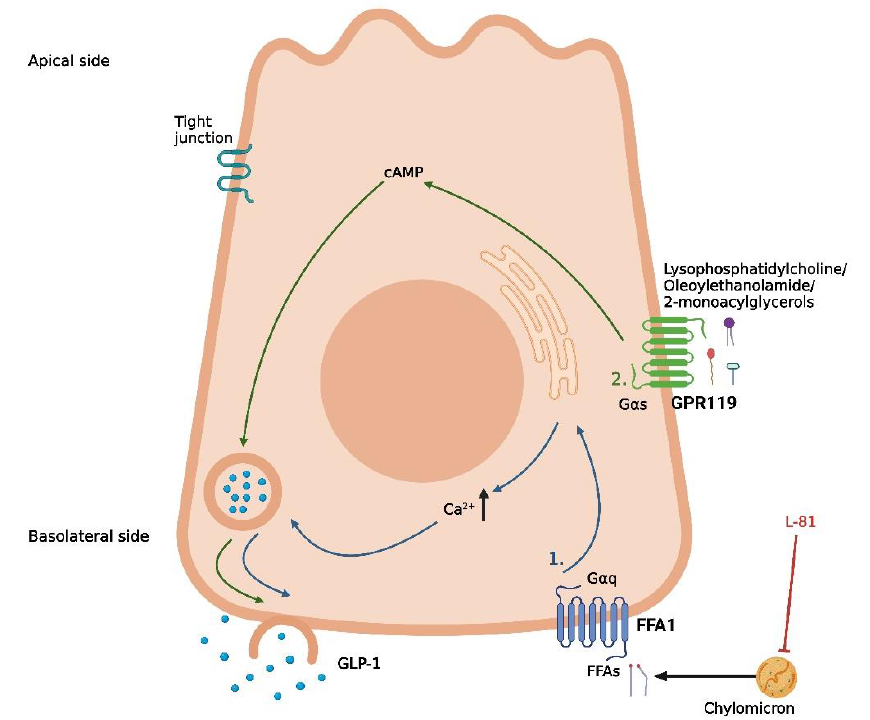
Figure 2. Proposed mechanisms of fat-induced GLP-1 secretion in intestinal L-cells. (1) Lipolysis of absorbed chylomicrons, followed by the activation of FFA1 by free fatty acids (FFAs), leading to the release of intracellular deposits of Ca 2+ . (2) Basolateral activation of GPR119 by lipid derivatives (lysophosphatidylcholine, oleoylethanolamide, and 2-monoacylglycerols), leading to an increase in cAMP. L-81 is a chylomicron inhibitor. The graphic was created with BioRender.com.